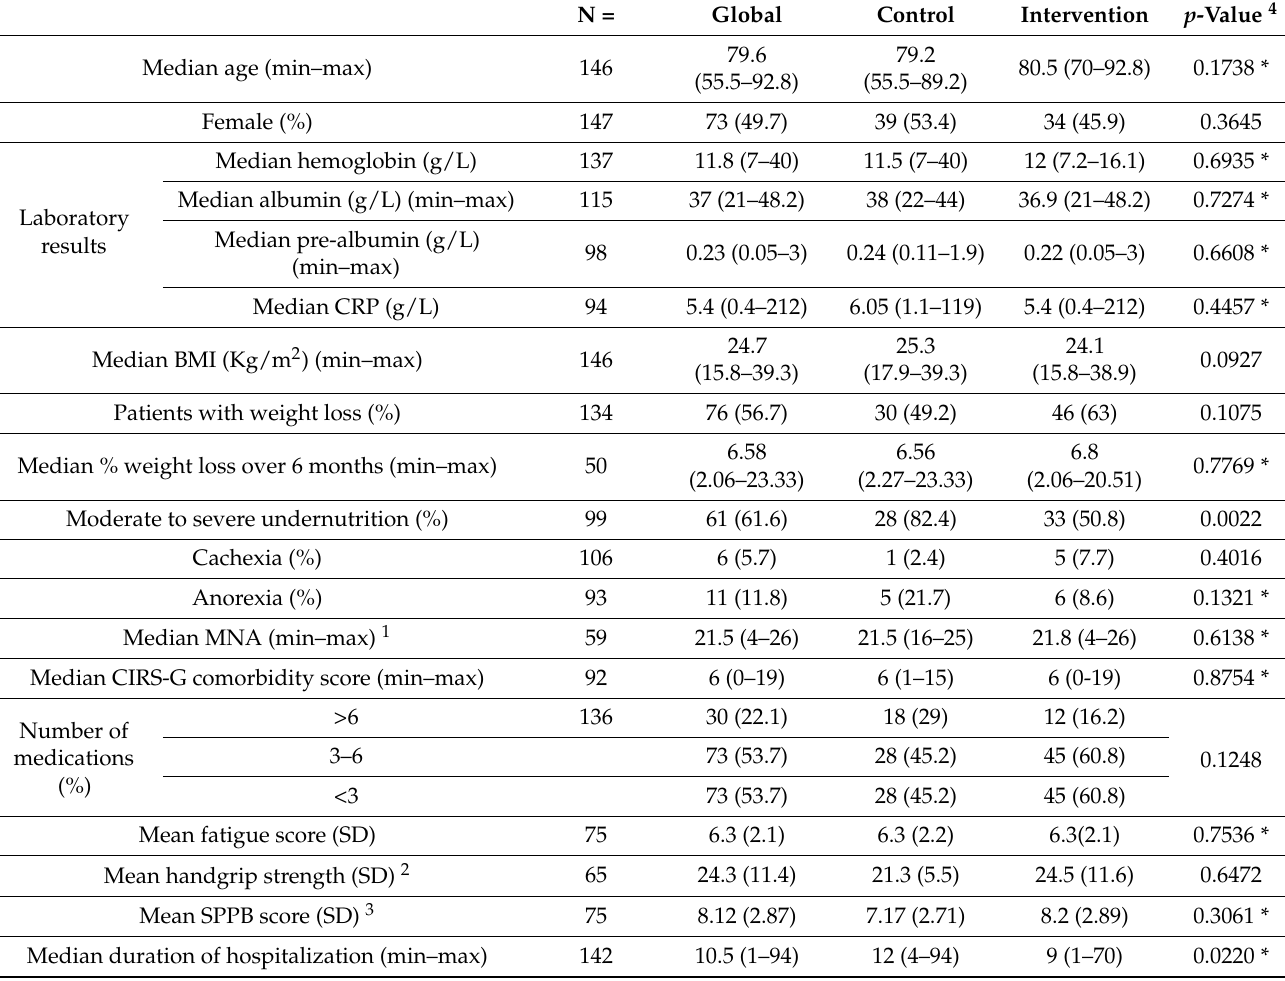
Table 2. Patient characteristics at